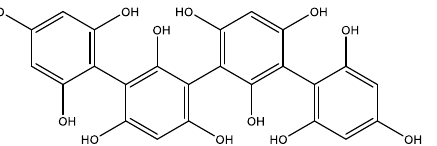
Figure 3. Tetrafucol A, a fucol-type phlorotannin found in the brown alga Ascophyllum nodosum (L.) Le Jolis.